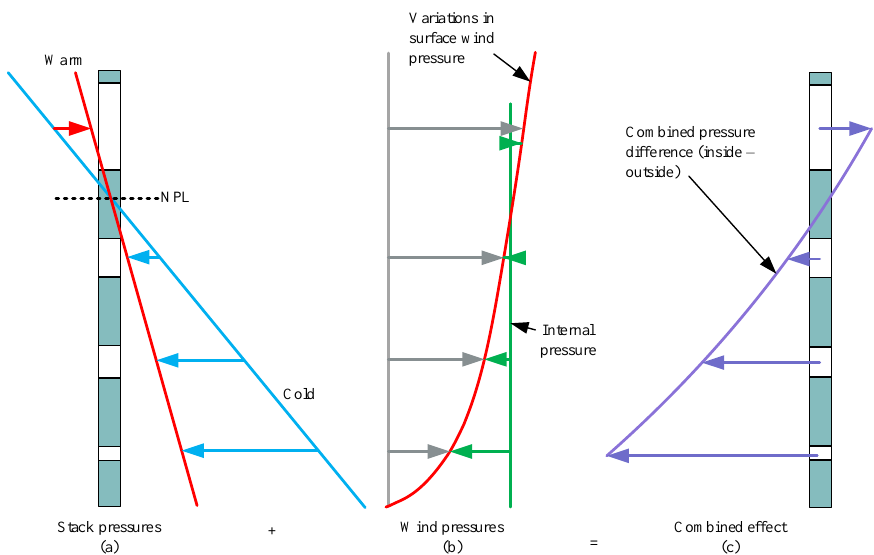
Fig. 1. Combining wind and stack pressures. Neutral pressure level (NPL) can be varied on changing the opening sizes